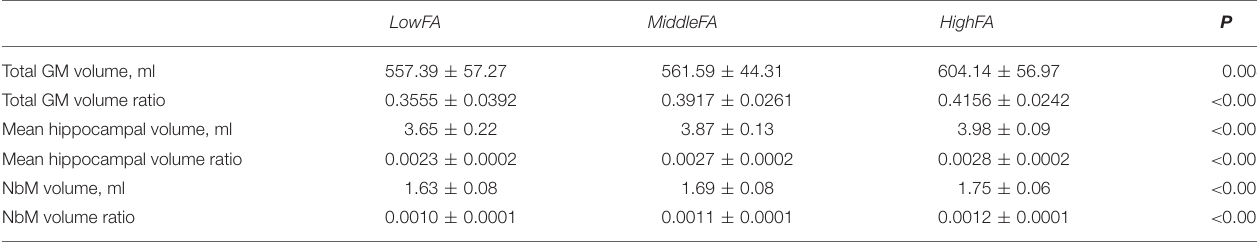
TABLE 3 | Brain volumes of the study participants by tertiles of FA